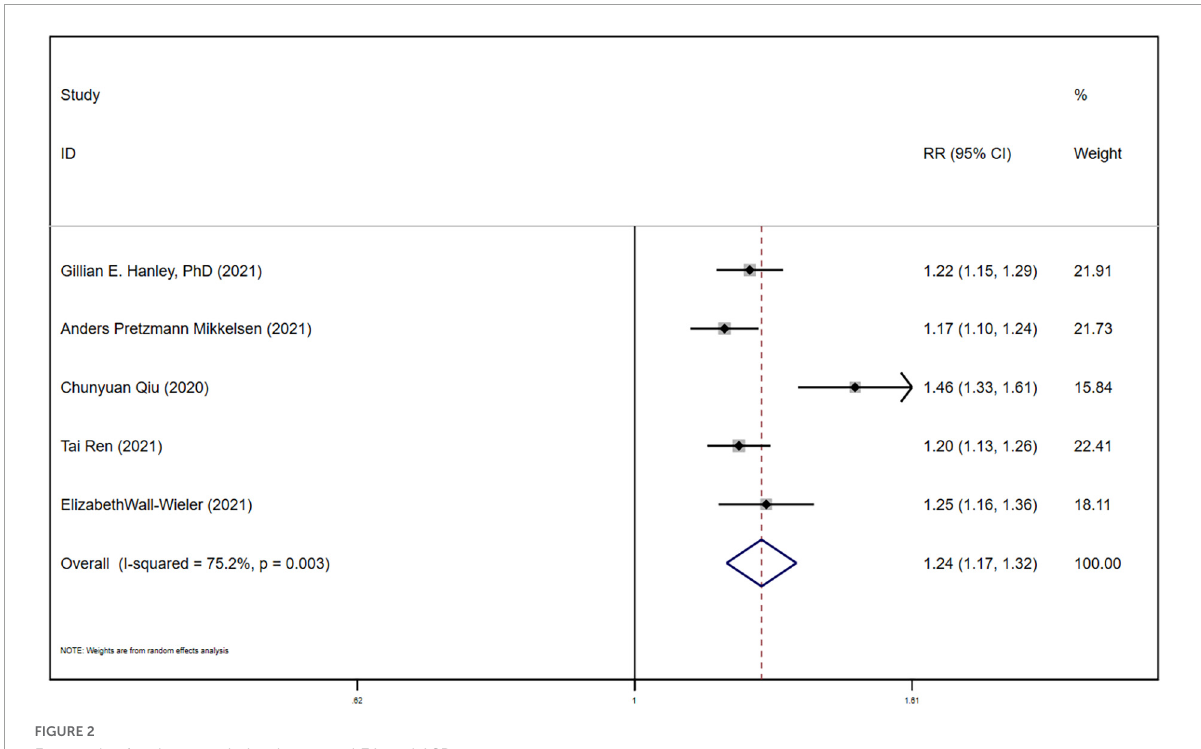
FIGURE2 Forest plot for the association between LEA and ASD.